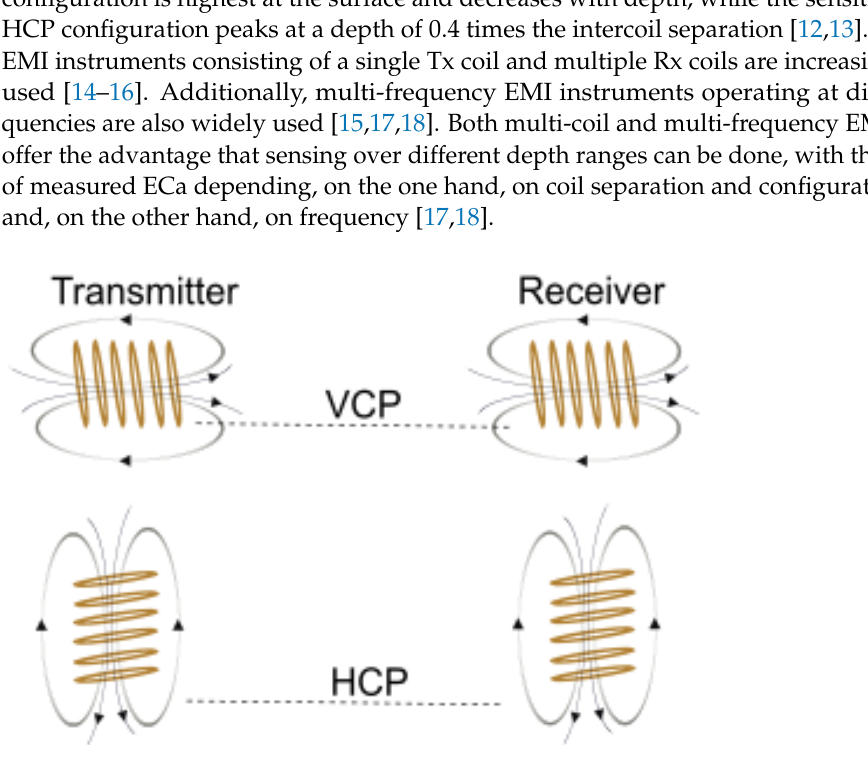
Figure 1. The vertical coplanar and horizontal coplanar coil configurations. The coils in VCP configuration have a dipole (arrow) horizontal to the plane of the soil. The coils in HCP configuration have a dipole (arrow) perpendicular to the plane of the surface.